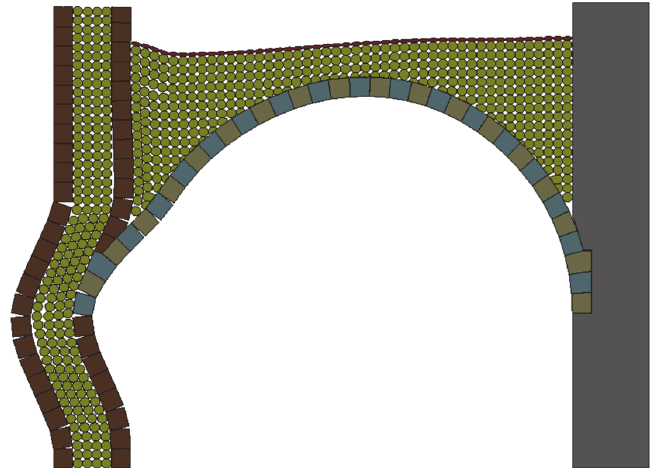
Figure 7: Deformed configuration after 0.9 sec for scenario S3